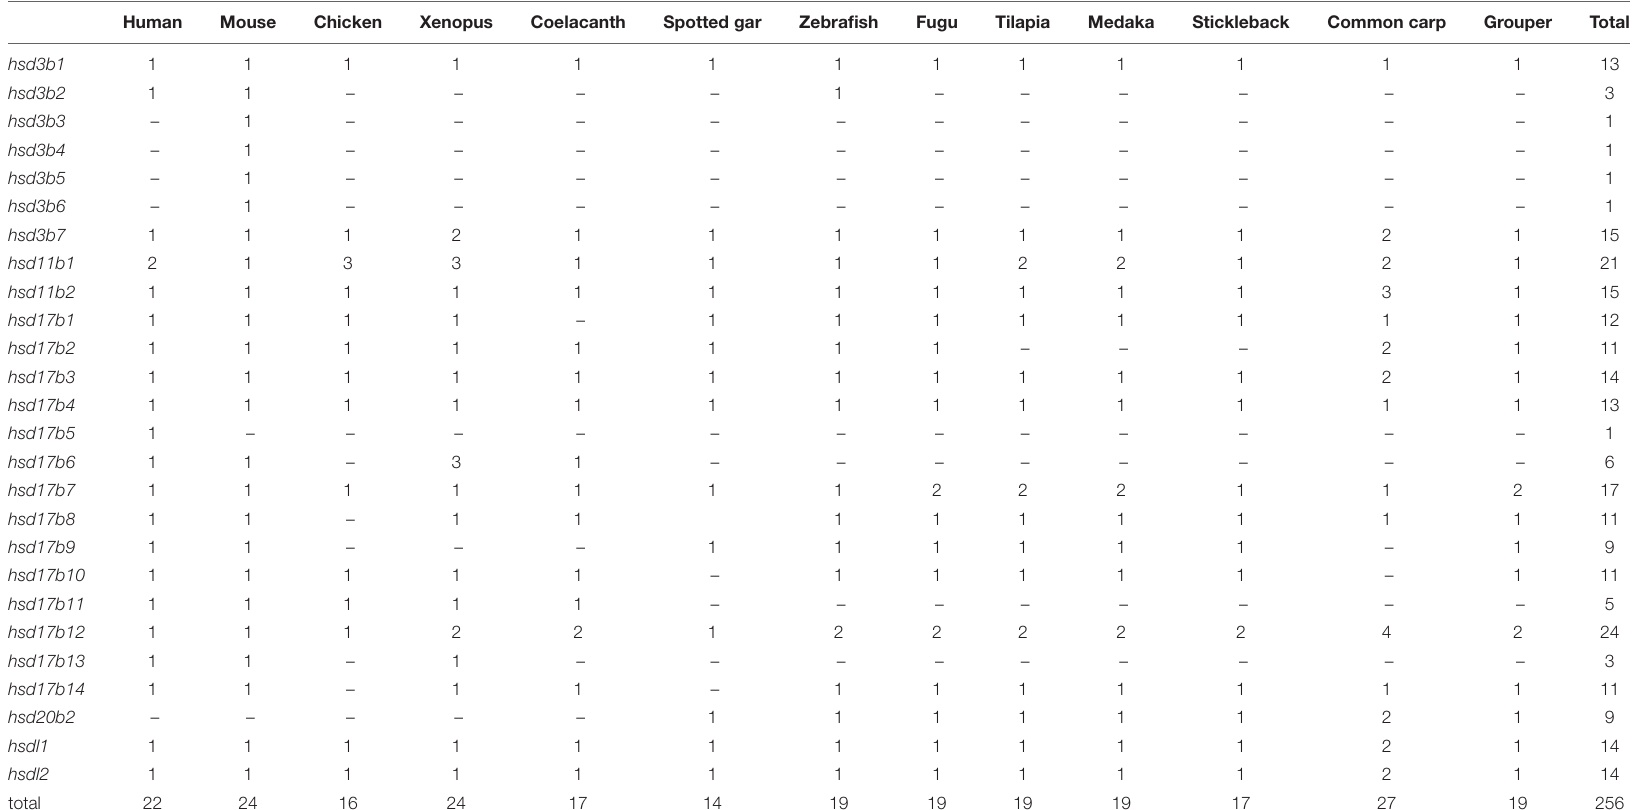
TABLE 1 | Number variation of β -hsd genes in the orange-spotted grouper and the other surveyed animals. Human Mouse Chicken Xenopus Coelacanth Spotted gar